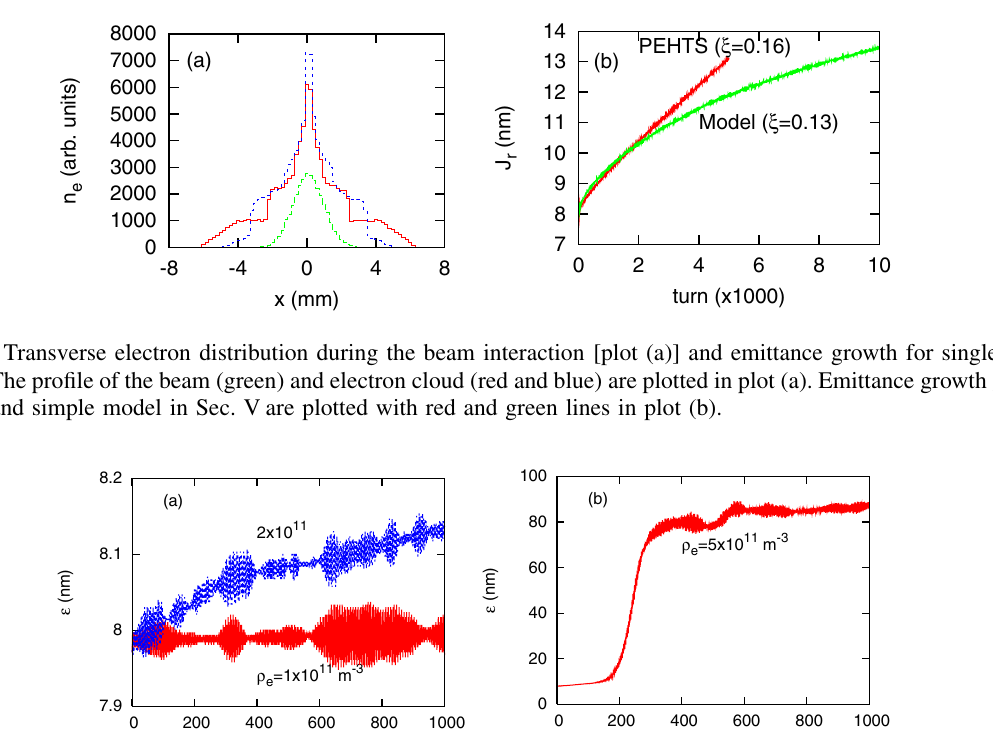
cloud interaction along the 2 (cid:7) structure, where e (cid:1) F i (cid:6) 1 ;i is to s . Since the beam-electron the linear map from s i i (cid:6) 1 cloud potential (cid:2) is symmetric for x ! (cid:1) x and y ! (cid:1) y , it is enough to consider a structure with (cid:7) phase advance.